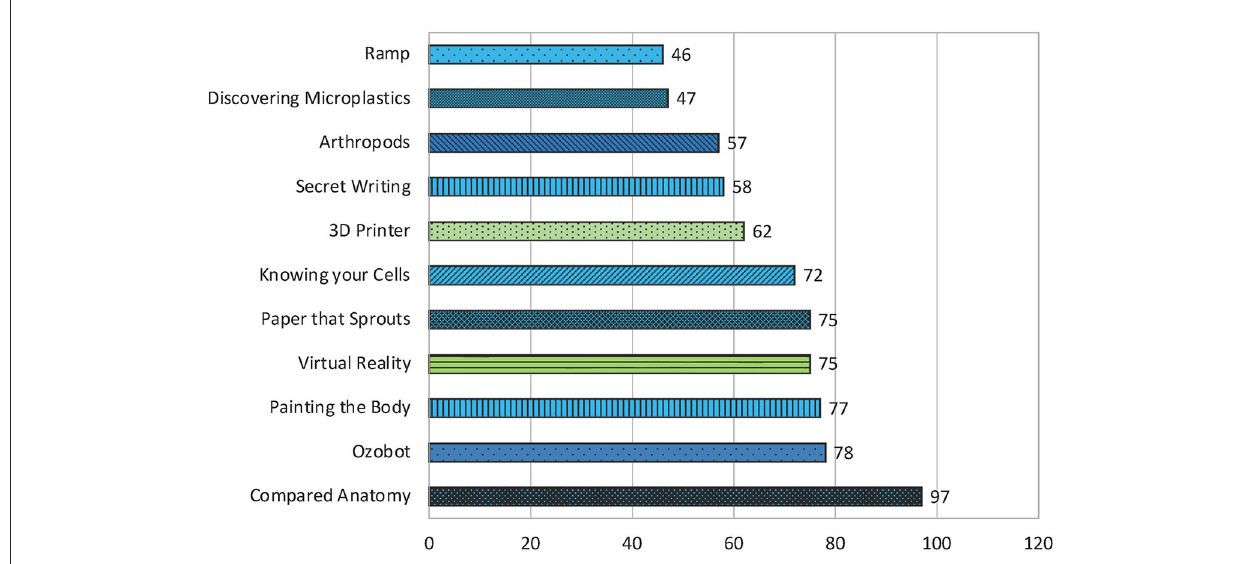
FIGURE1 Actual number of students that answered the questionnaires in each activity n =